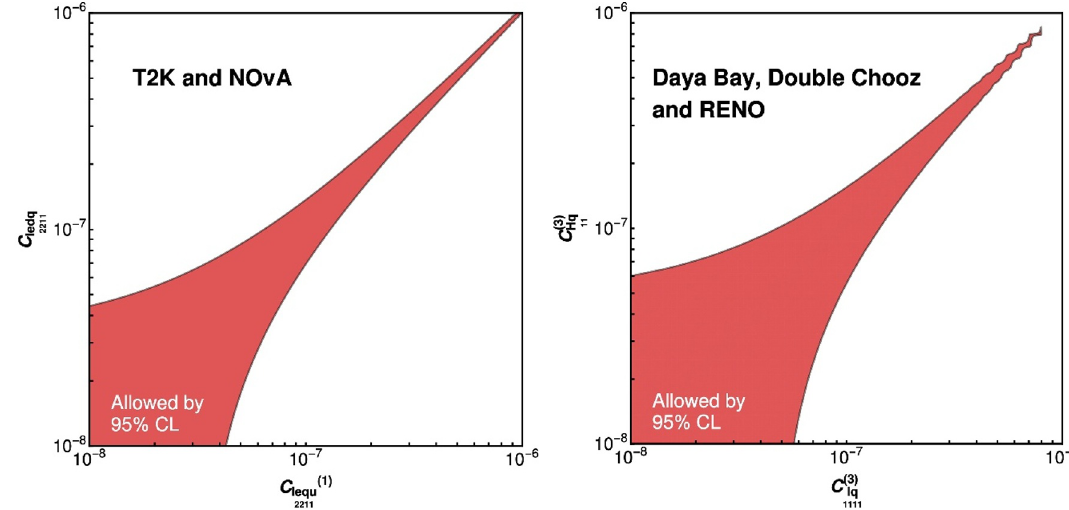
Figure 11 . Left panel: upper constraints on the Wilson coefficients corresponding to the opera- tors (¯ ‘ 2 e 2 ) ε jk (¯ q 1 u 1 ) and (¯ ‘ 2 e 2 )( ¯ d 1 q 1 ) with Λ = 1 TeV. The constraints are obtained for the LBL experiments T2K and NO ν A at 95% CL significance. Right panel: same as the left panel but with the application of Daya Bay, Double Chooz and RENO on operators (¯ ‘ 1 σ µν e 1 ) ε jk (¯ q 1 σ µν u 1 ) and ( H † i ~D µ H )(¯ q 1 τ I γ µ q 1 )